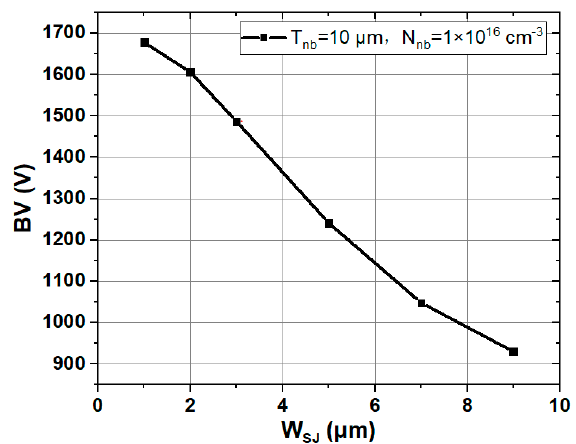
Figure 5. BV of SJ SiC DSRD with different W SJ . ( T nb of 10 μ m, N nb of 1 × 10 16 cm − 3